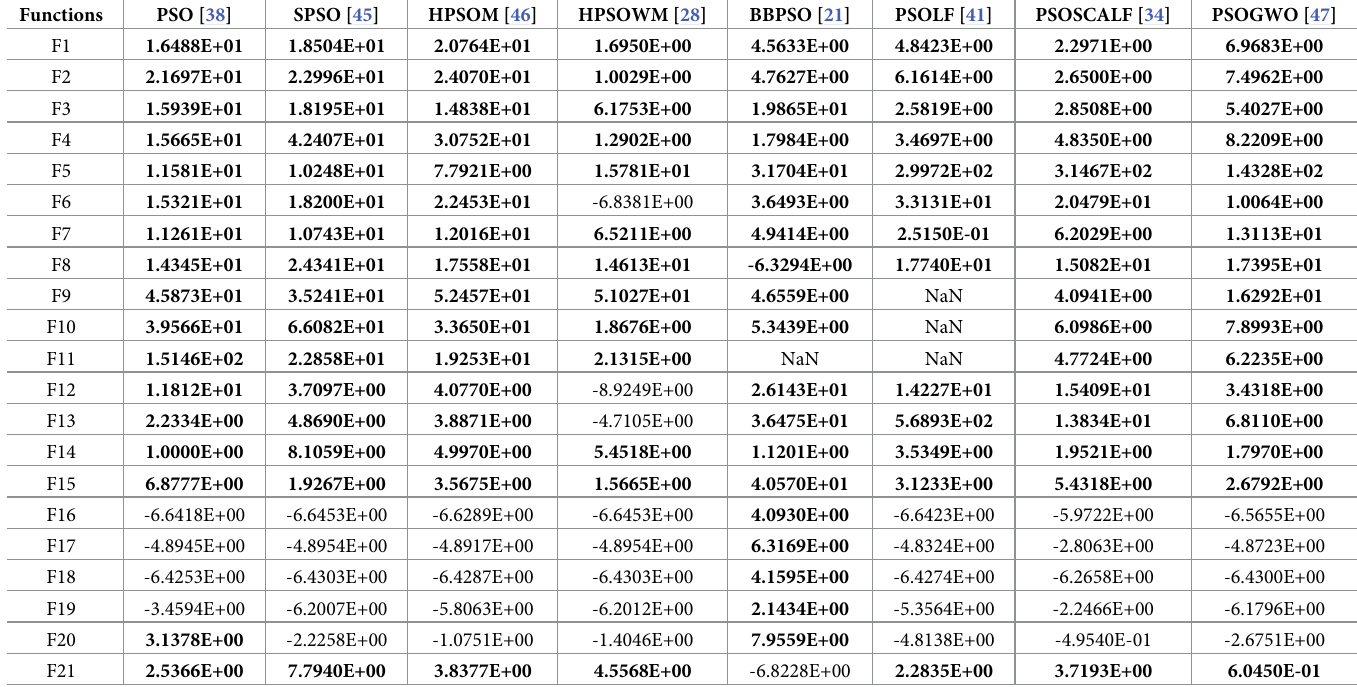
Table 3. Comparison of PSOLFWM with PSO families algorithms using